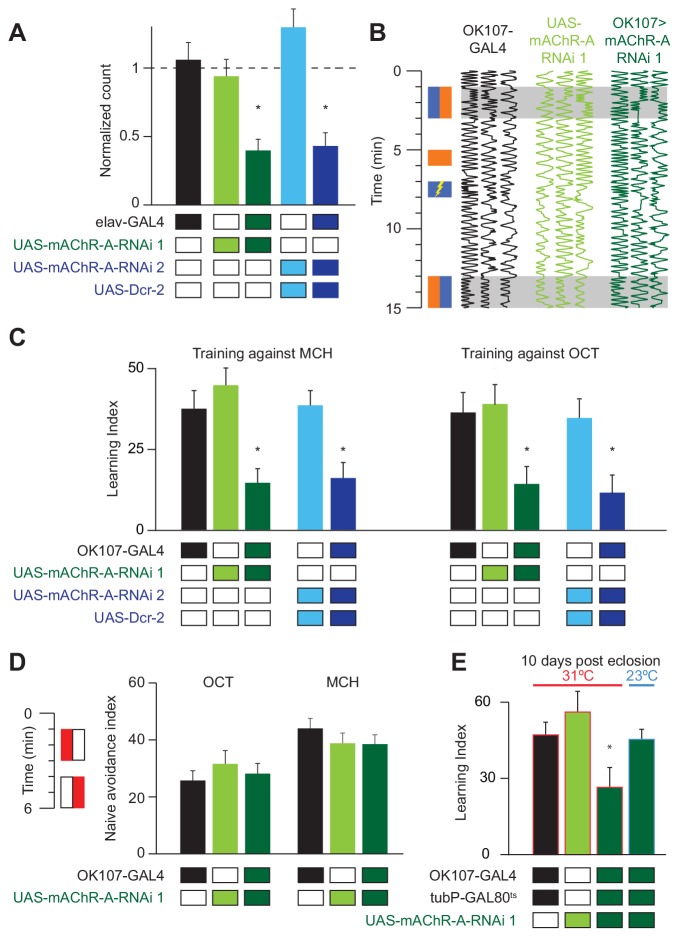
mAChR-A is required in the MB for short-term aversive olfactory learning and memory but not for naive behavior.(A) qRT-PCR of mAChR-A with mAChR-A RNAi driven by elav-GAL4. The housekeeping gene eEF1α2 (eukaryotic translation elongation factor 1 alpha 2, CG1873) was used for normalization. Knockdown flies have ~40% of the control levels of mAChR-A mRNA (mean ± SEM; number of biological replicates (left to right): 6, 7, 7, 4, 4, each with three technical replicates; *p<0.05; Kruskal-Wallis test with Dunn’s multiple comparisons test and Welch ANOVA test with Dunnett’s T3 multiple comparisons test). For detailed statistical analysis see Supplementary file 1. (B) Each trace shows the movement of an individual fly during the training protocol, with fly position in the chamber (horizontal dimension) plotted against time (vertical dimension). Colored rectangles illustrate which odor is presented on each side of the chamber during training and testing. Flies were conditioned against MCH (blue rectangles; see Materials and methods). (C) Learning scores in flies with mAChR-A RNAi driven by OK107-GAL4. mAChR-A knockdown reduced learning scores compared to controls (mean ± SEM, n (left to right): 69, 69, 70, 71, 71, 47, 48, 53, 58, 51 *p<0.05; Kruskal-Wallis test with Dunn’s multiple comparisons test). (D) mAChR-A knockdown flies show normal olfactory avoidance to OCT and MCH compared to their genotypic controls (mean ± SEM, n (left to right): 68, 67, 58, 63, 91, 67, p=0.82 for OCT, p=0.64 for MCH; Kruskal-Wallis test). Colored rectangles show stimulus protocol as in (B); red for odor (MCH or OCT), white for air. (E) Learning scores in flies with mAChR-A RNAi 1 driven by OK107-GAL4 with GAL80ts repression. Flies raised at 23°C and heated to 31°C as adults (red outlines) had impaired learning compared to controls. Control flies kept at 23°C throughout (blue outline), thus blocking mAChR-A RNAi expression, showed no learning defects (mean ± SEM, n (left to right): 51, 41, 58, 51, **p<0.05, Kruskal-Wallis test with Dunn’s multiple comparisons test). For detailed statistical analysis see Supplementary file 1.10.7554/eLife.48264.006Figure 1—source data 1.Source data for Figure 1A.10.7554/eLife.48264.007Figure 1—source data 2.Source data for Figure 1C–E.